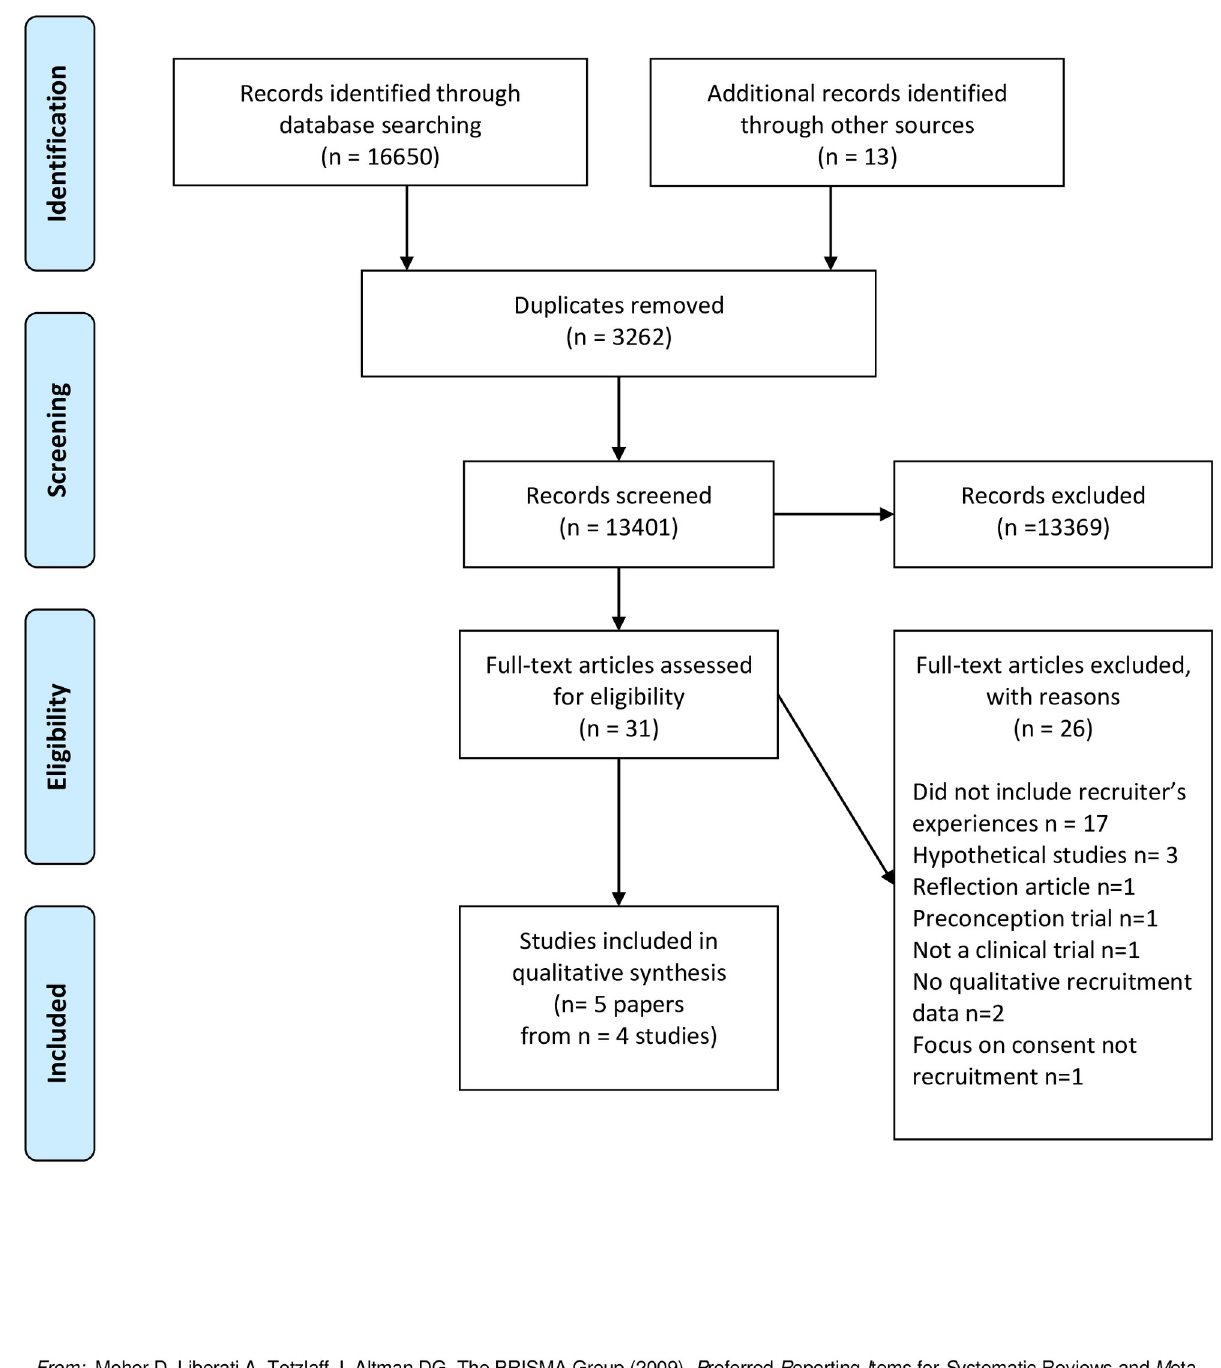
Fig 1. PRISMA flow diagram.